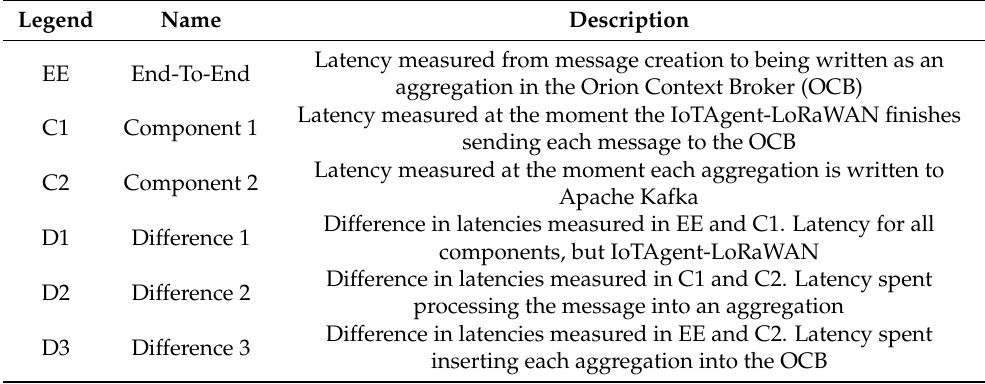
Table 2. Mappings for figure legends, defining measuring points for